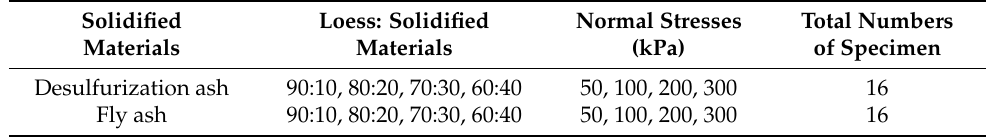
Table 5. Direct shear test